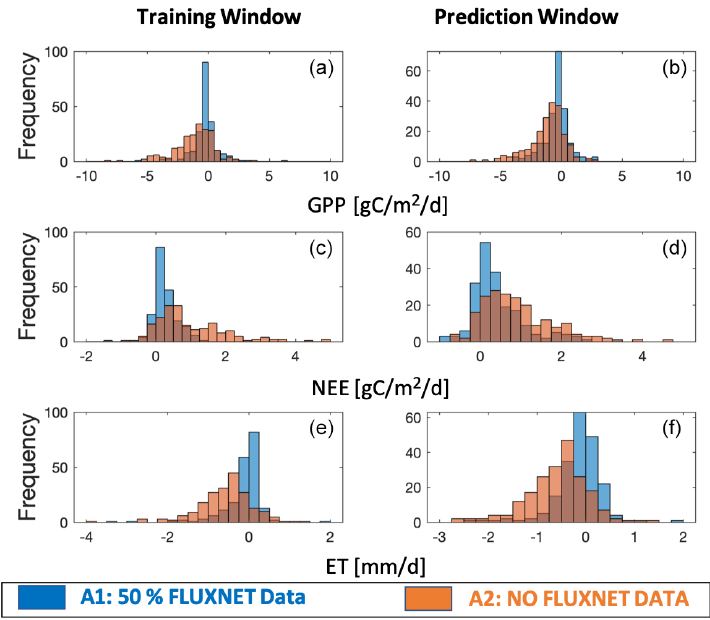
Figure 4. Histogram of site-level residuals over all sites for the assimilation window (a, c, e) and prediction window (b, d, f) . Residuals are the differences between model outputs (GPP, NEE, and ET) and observations (GPP, NEE, and ET measured at tower sites). Two different CARDAMOM runs are shown as A1 and A2 (A1 means model simulations using 50% FLUXNET data as constraints; A2 means baseline model simulations with no FLUXNET constraints). Table 3. Site-level residuals in assimilation and prediction windows (Fig.